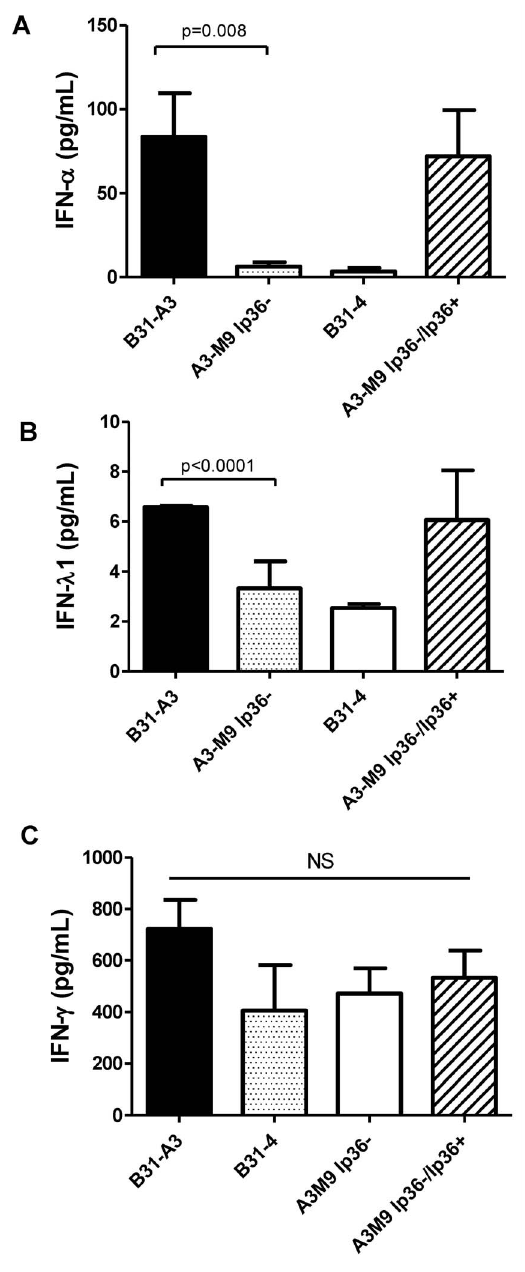
Figure 2. The presence of lp36 is required for IFN- a and IFN- l induction. Human PBMCs (4 6 10 6 ) were co-incubated for 20 hrs with 4 6 10 7 wt B31-A3 (black bars), B31-4 (gray bars), A3-M9 lp36 2 (white bars) or A3-M9 lp36 2 /lp36 + (cross-hatched bar)(MOI=10). Protein concentrations of human IFN- a ( A ), IFN- l 1 ( B ), or IFN- c ( C ) in cell-free culture supernatants were quantitated by ELISA ( A , B ) or cytometric bead array ( C ). The results are shown as the mean 6 SD of values from three to five blood donors assessed in two or three independent experiments. Statistics were obtained using a non-parametric Mann- Whitney